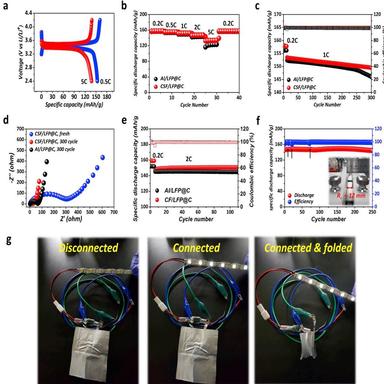
Applications for lithium-ion energy storage. a-c Electrochemical properties of coin-type cells. a Charge-discharge profiles of the CSF/LFP@C electrode at different rates. b Rate capability of the Al/LFP@C and CSF/LFP@C composite electrode. c Cycling performance of the Al/LFP@C and CSF/LFP@C composite electrode at a rate of 1 C after 10 cycles at a rate of 0.2C. d Nyquist plots of Al/LFP@C and CSF/LFP@C electrodes before and after cycles. e-g Electrochemical properties and the corresponding digital images of